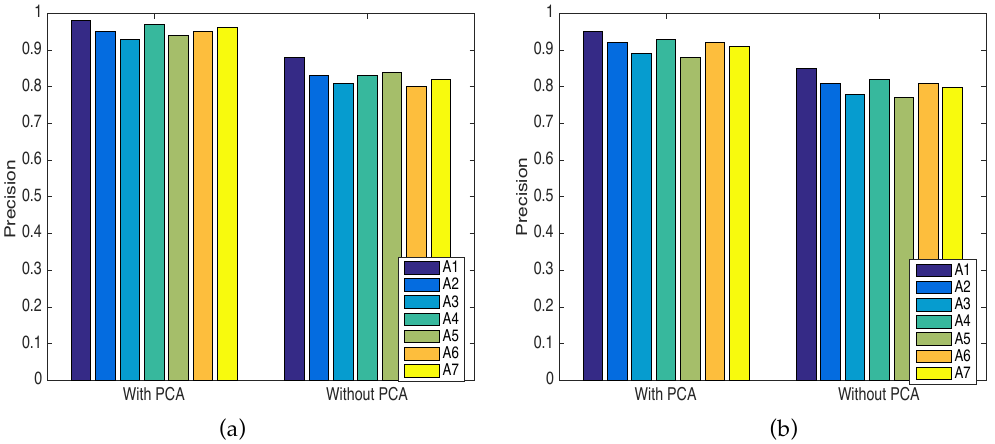
Figure 7. Comparison of system precision with PCA method and without PCA. ( a ) Comparison results in the LOS scenario; ( b ) Comparison results in the NLOS scenario.